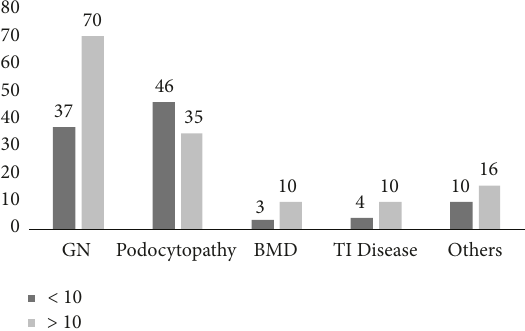
Figure 4: Biopsy diagnosis according to age group. GN: glomeru- lonephritis; TI: tubulointerstitial; BMD: basement membrane dis-